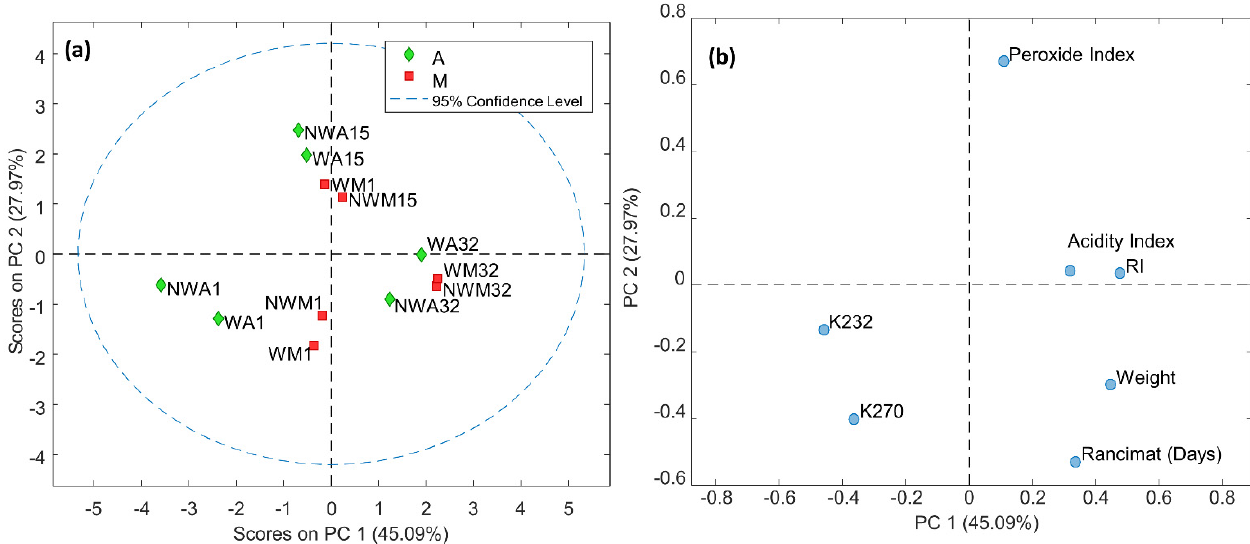
Figure 1. Scores ( a ) and loadings ( b ) plots of the PCA model obtained with physicochemical parameters, Ripening Index (RI), oxidative stability (Rancimat results) of the Organic Extra Virgin Olive Oil samples (OEVOOs) analyzed according to the washing (W) or non-washing (NW) process, the time of collection (Morning-M or Afternoon-A), and maturation stage (I–III). Stage I (collection day 1), stage II (collection day 15), stage III (collection day 32).